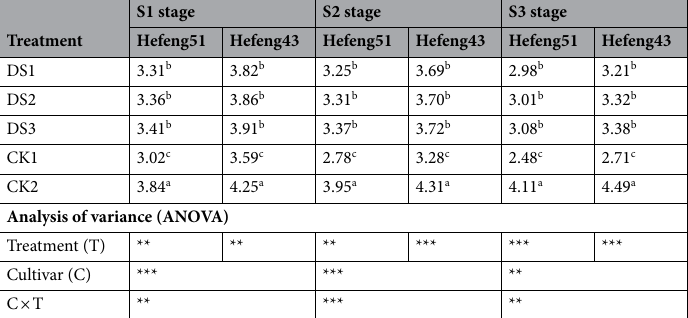
Table 1. Effects of foliar α-oxoglutarate and nitrogen on fresh weight under drought stress (g plant −1 ). Means with same letter within columns are not significantly different ( P < 0.05) using LSD test. ***, **Significance at 0.001 and 0.01,